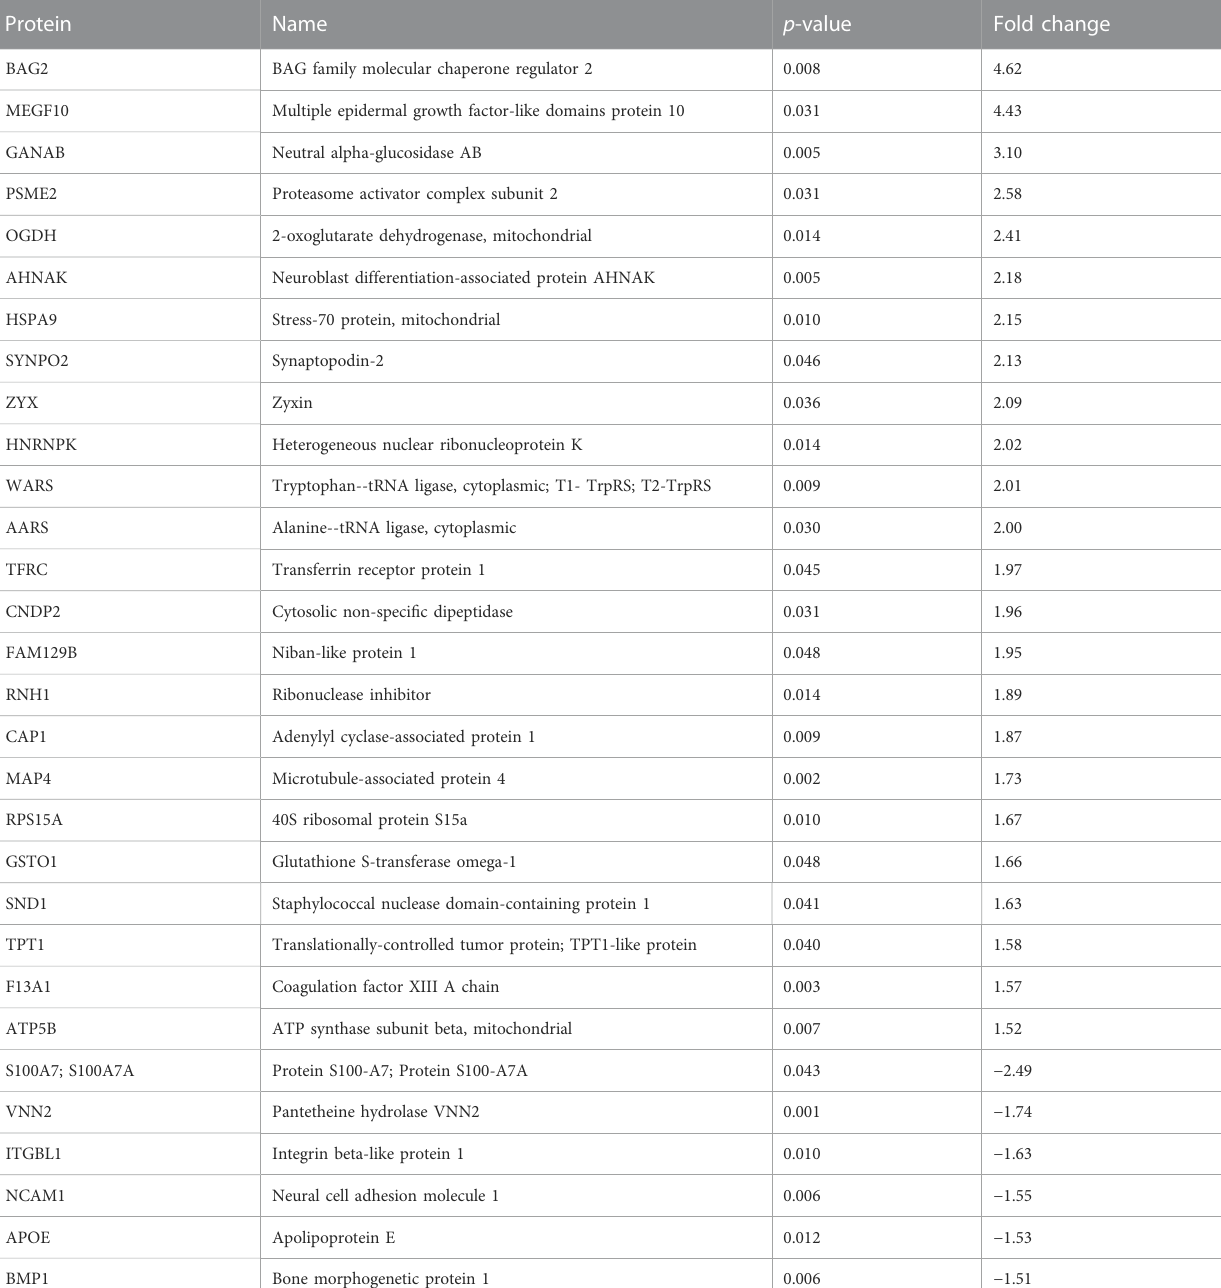
TABLE 2 The exosome proteins that were most ( > 1.5-fold) changed by EPS. Protein